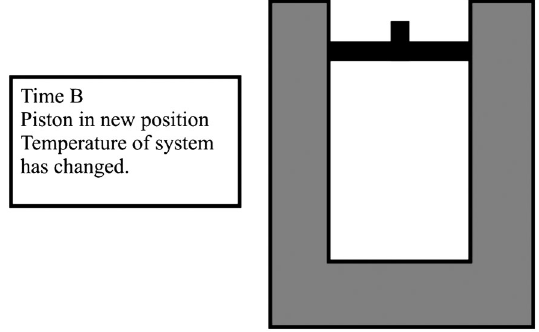
FIG. 4. The ideal gas system at time B.